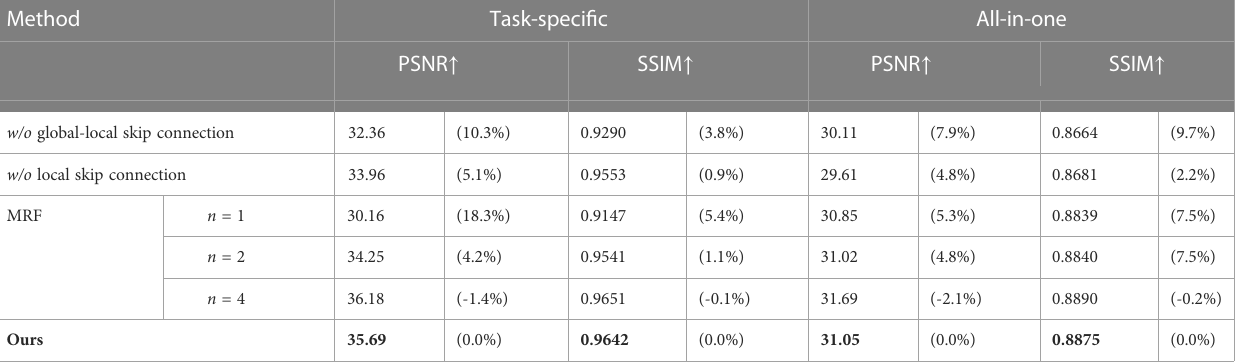
TABLE 4 Ablation study on individual components of the proposed